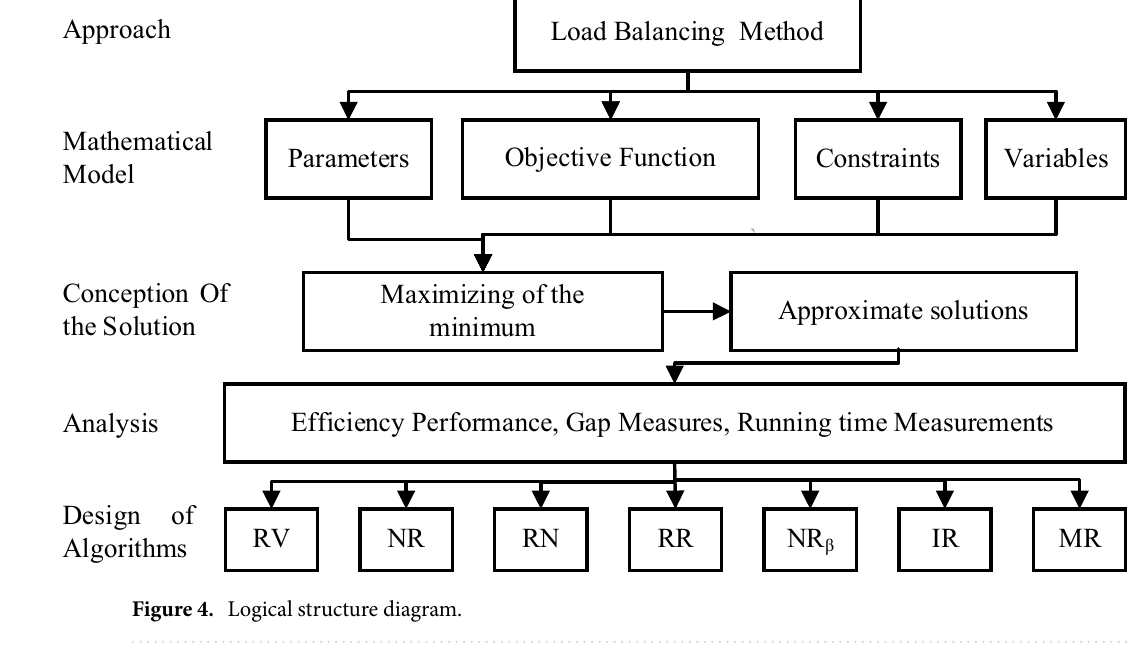
Figure 4. Logical structure diagram.